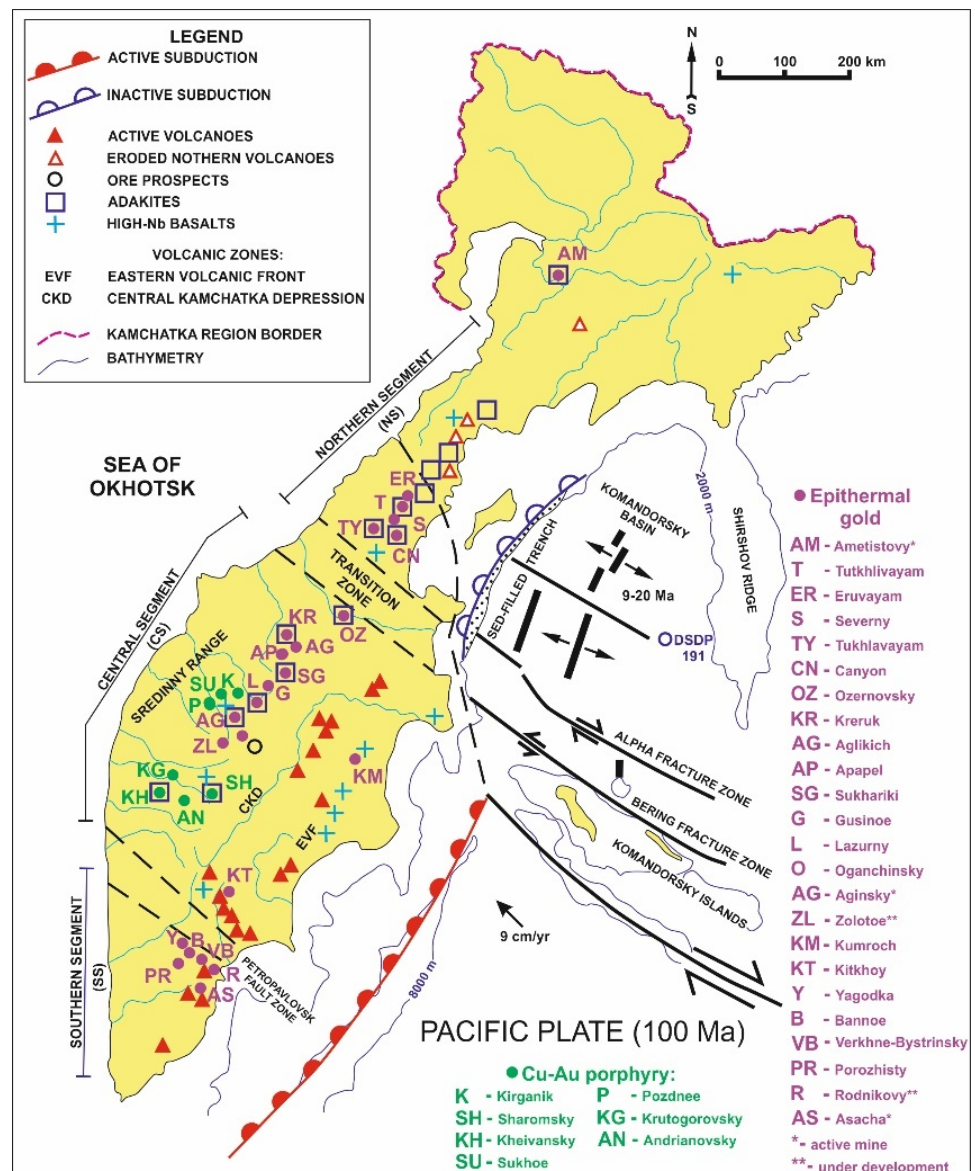
Figure 5. Tectonic setting of copper–gold porphyry and epithermal gold deposits in Kamchatka in reference to regional distribution of adakites and high-Nb basalts.